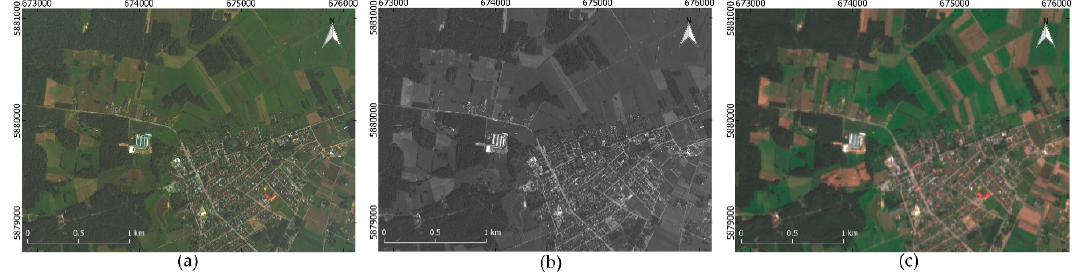
Figure 1. The data used for the research: ( a ) aerial MS (multispectral) image, ( b ) aerial PAN (panchromatic) image, and ( c ) satellite MS imagery. Table 1. The sensitivity of aerial (DMC II 230) and satellite sensors (S2A); the values for the aerial sensor were read from the camera calibration report and are approximate values.